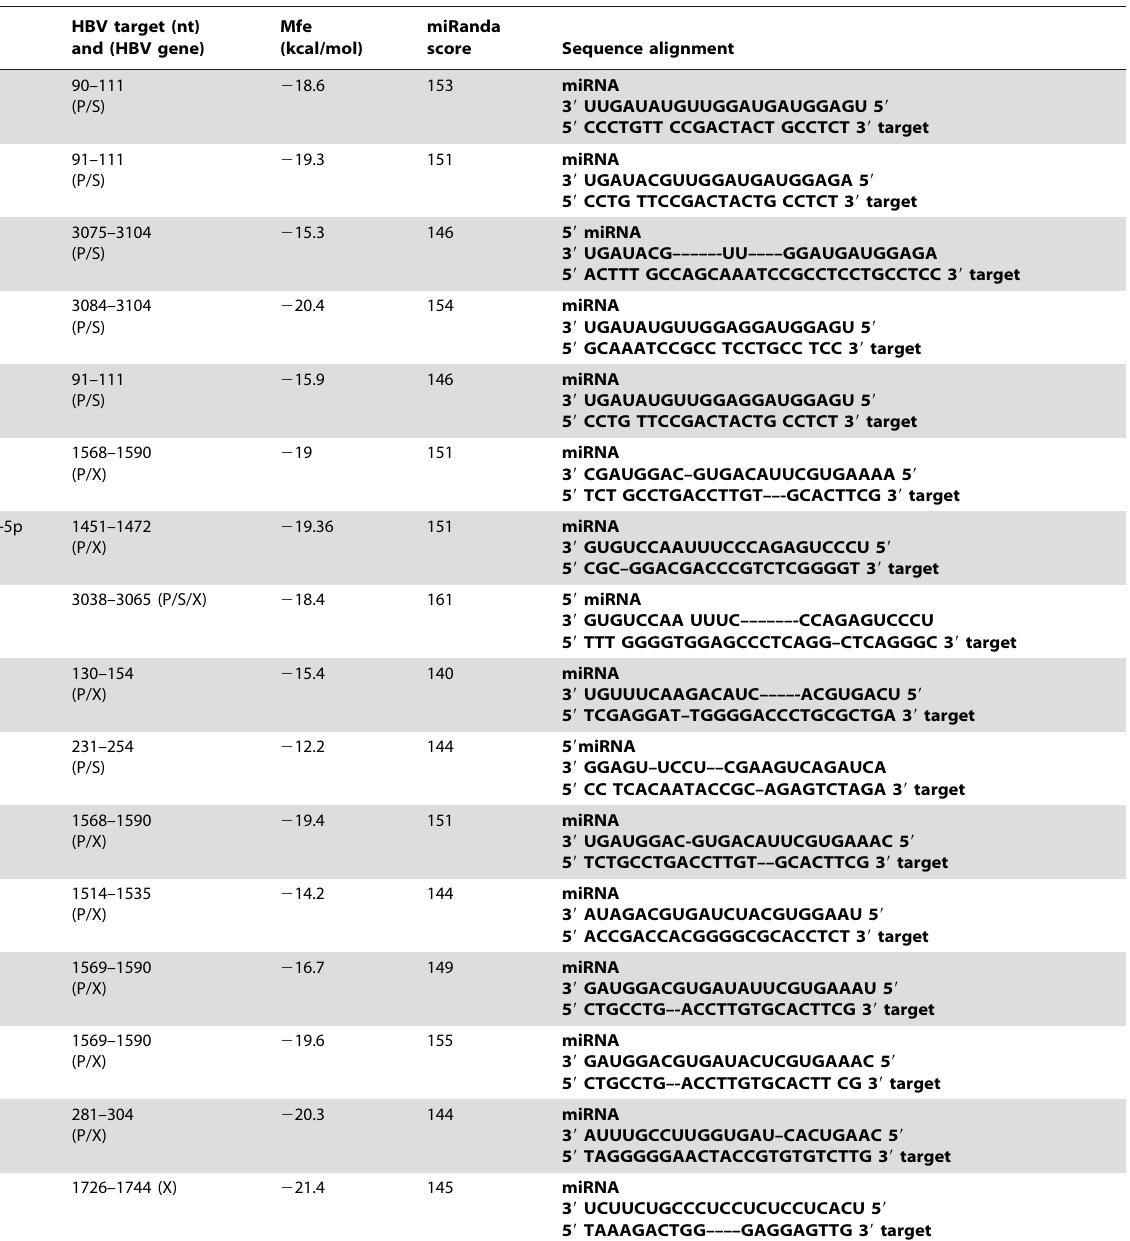
Table 3. Properties of miRNA capable of targeting HBV.